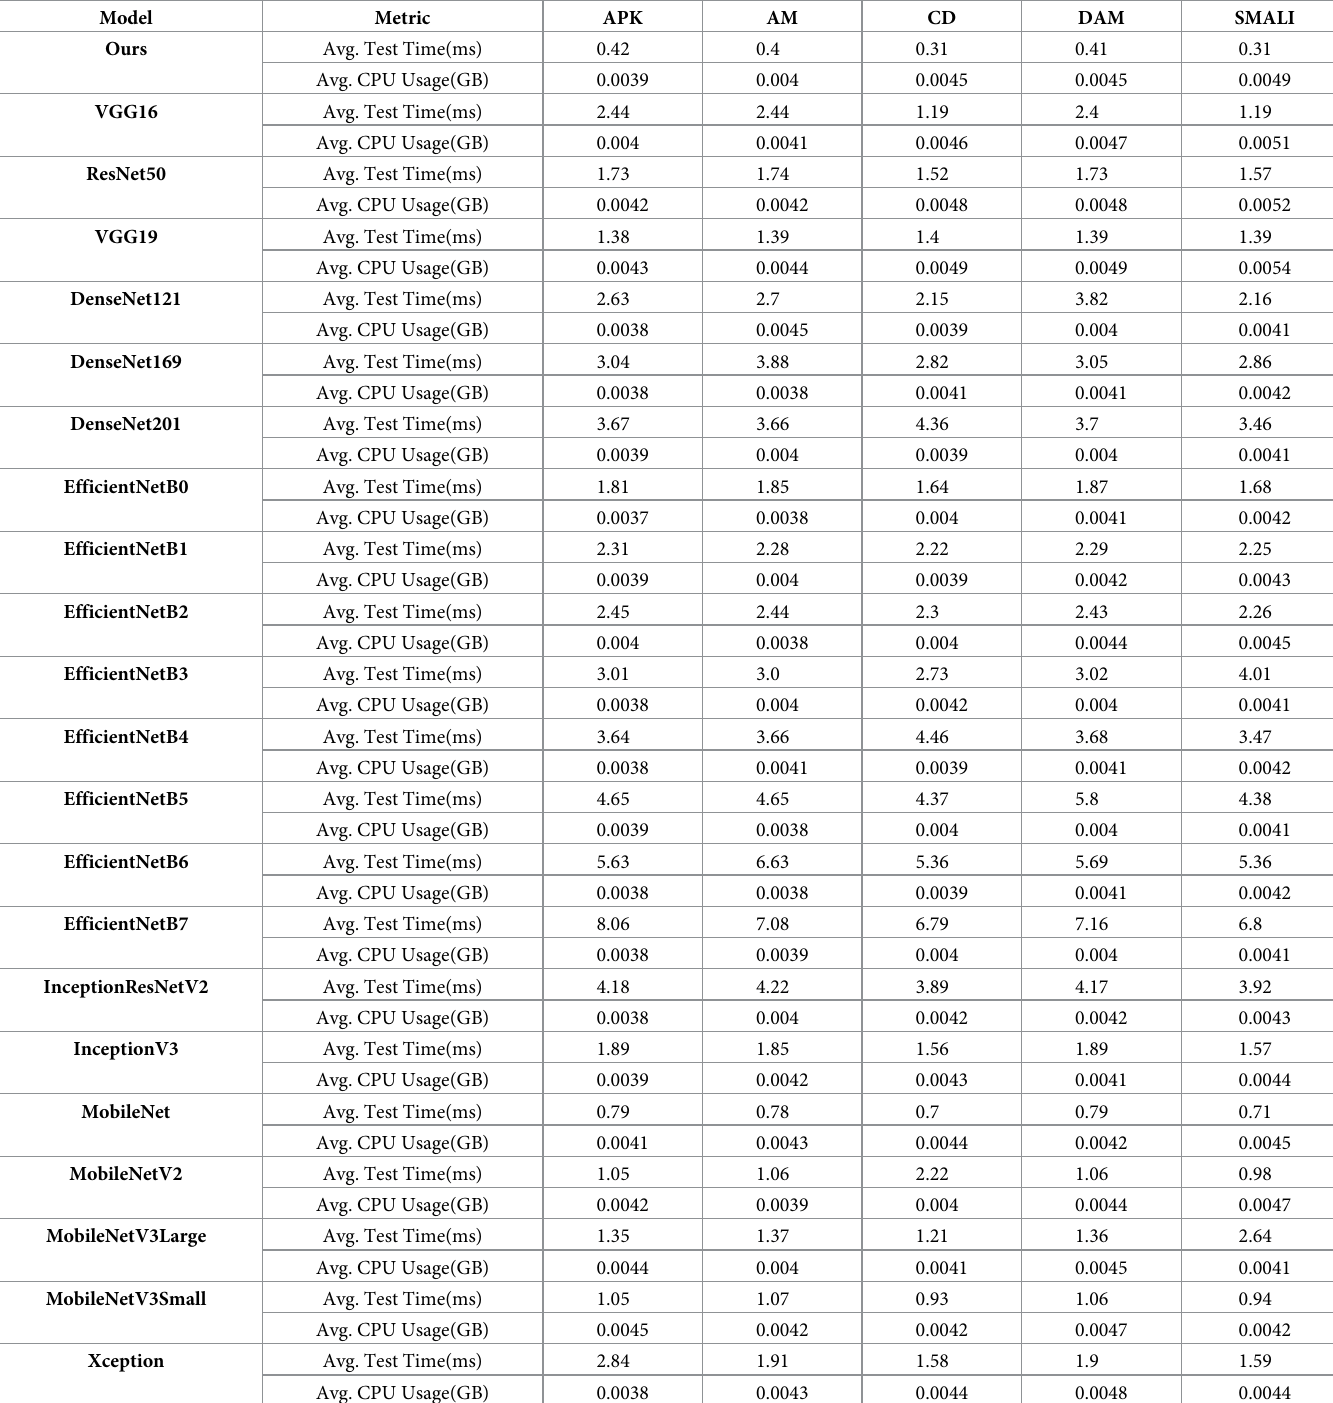
Table 9. Complexity performance of models on AMD